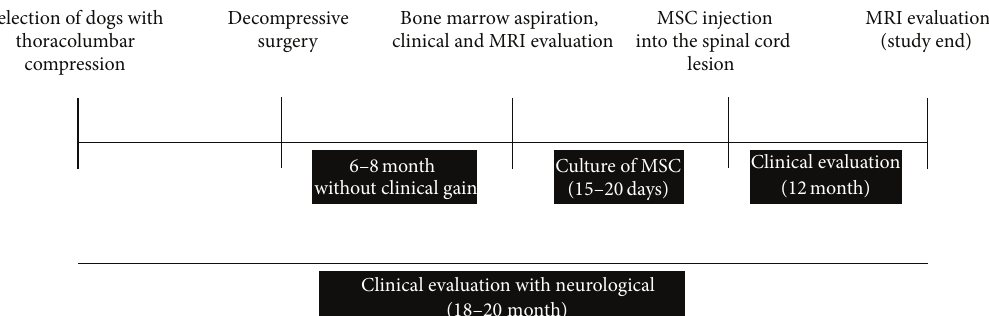
Figure 1: Data acquisition schematic and methods.